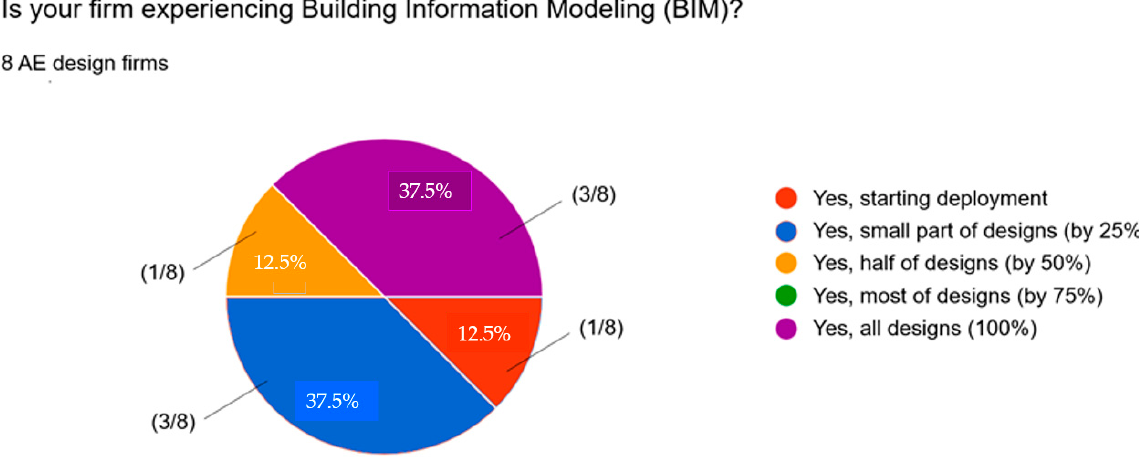
Figure 2. Design firms’ experiences with